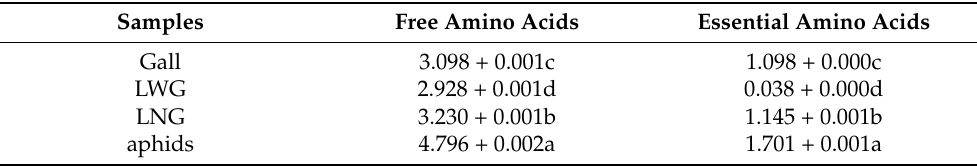
Table A11. The content of free amino acids and essential amino acids in different